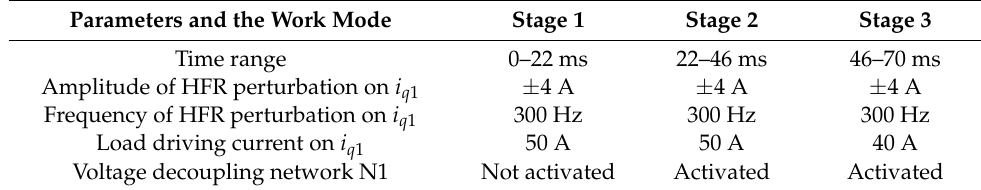
Table 3. Parameters and the work mode in three stages.